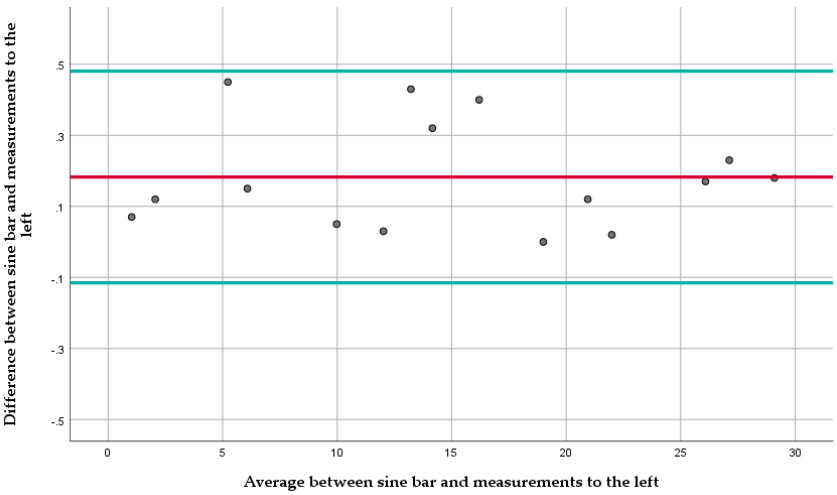
Figure 6. The Bland-Altman plot for measurements to the left. The red line represents the average difference between the sine bar set angles and the mean measurements, and the green lines, the 95% CI.